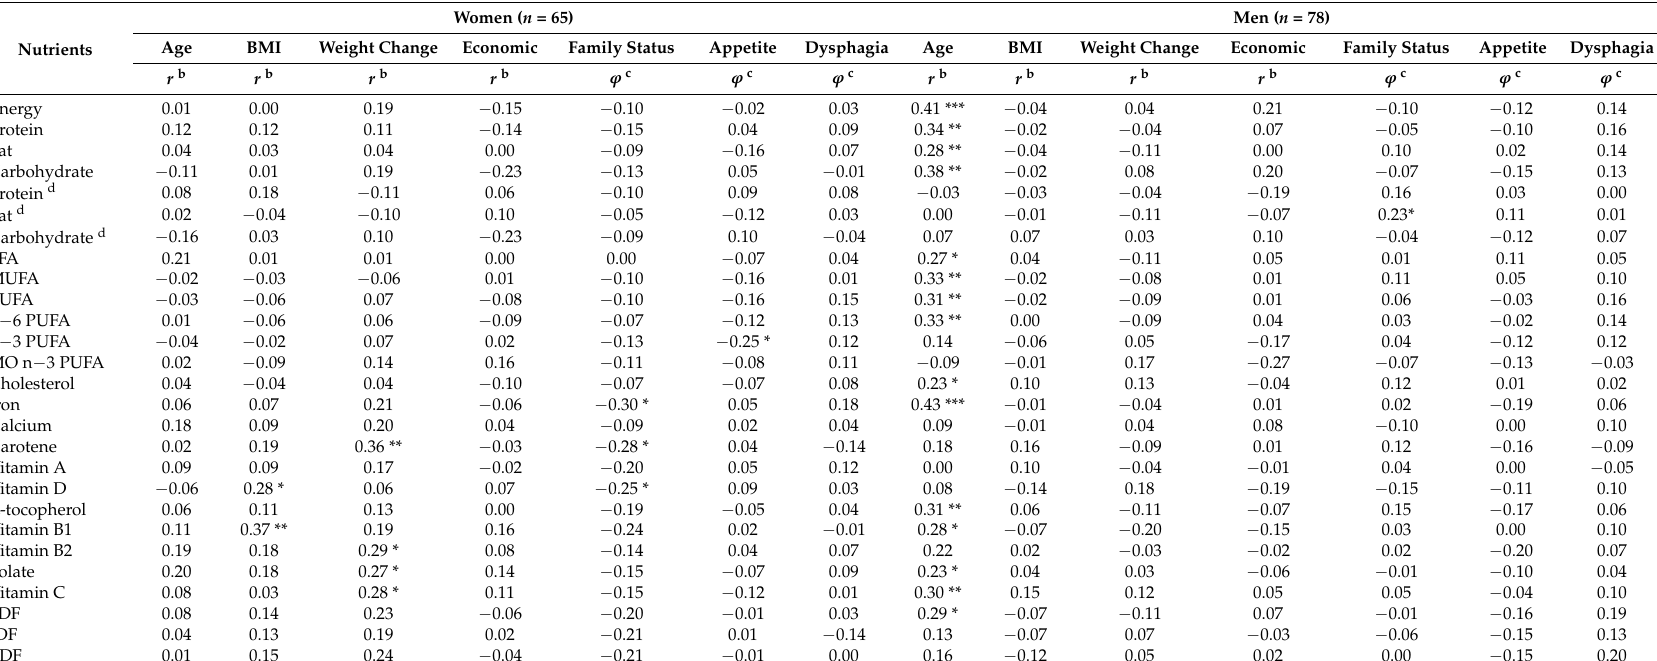
Table 4. Spearman rank correlation analysis between the measurement error and variables according to sex a